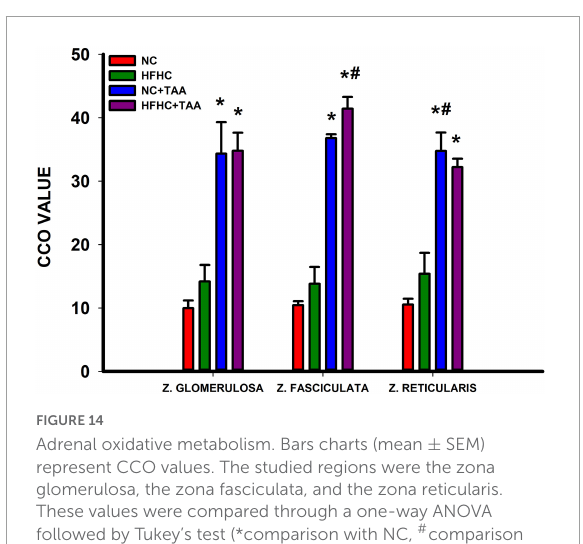
FIGURE14 Adrenal oxidative metabolism. Bars charts (mean ± SEM) represent CCO values. The studied regions were the zona glomerulosa, the zona fasciculata, and the zona reticularis. These values were compared through a one-way ANOVA followed by Tukey’s test (*comparison with NC, # comparison with HFHC; * # p <